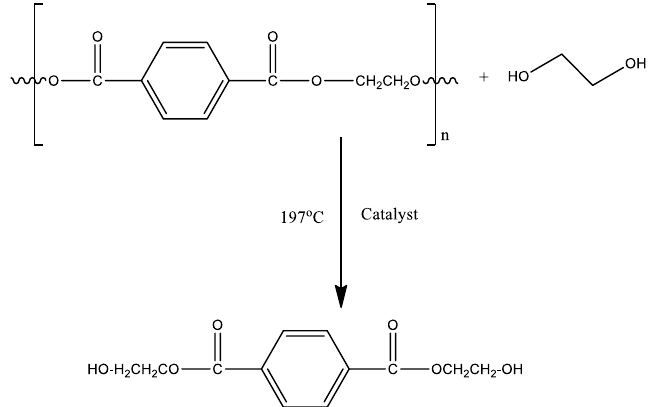
Figure 1. Chemical depolymerization of (PET) n into product bis(2-hydroxyethyl) terephthalate BHET.